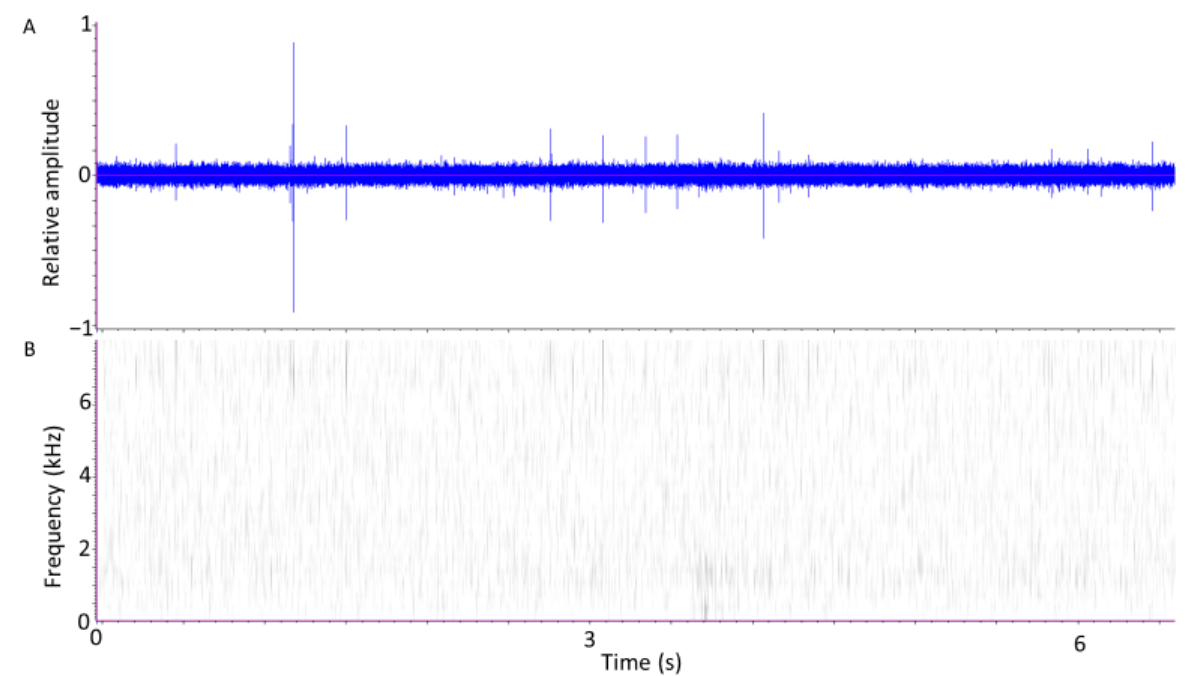
Figure 2. ( A ) Oscillogram and ( B ) Spectrogram of a 6.7 s interval of feeding sounds recorded from S. oryzae larvae. Darker areas in the spectrogram (calculated at 128 points/spectrum) indicate greater energy at specific frequencies and times.